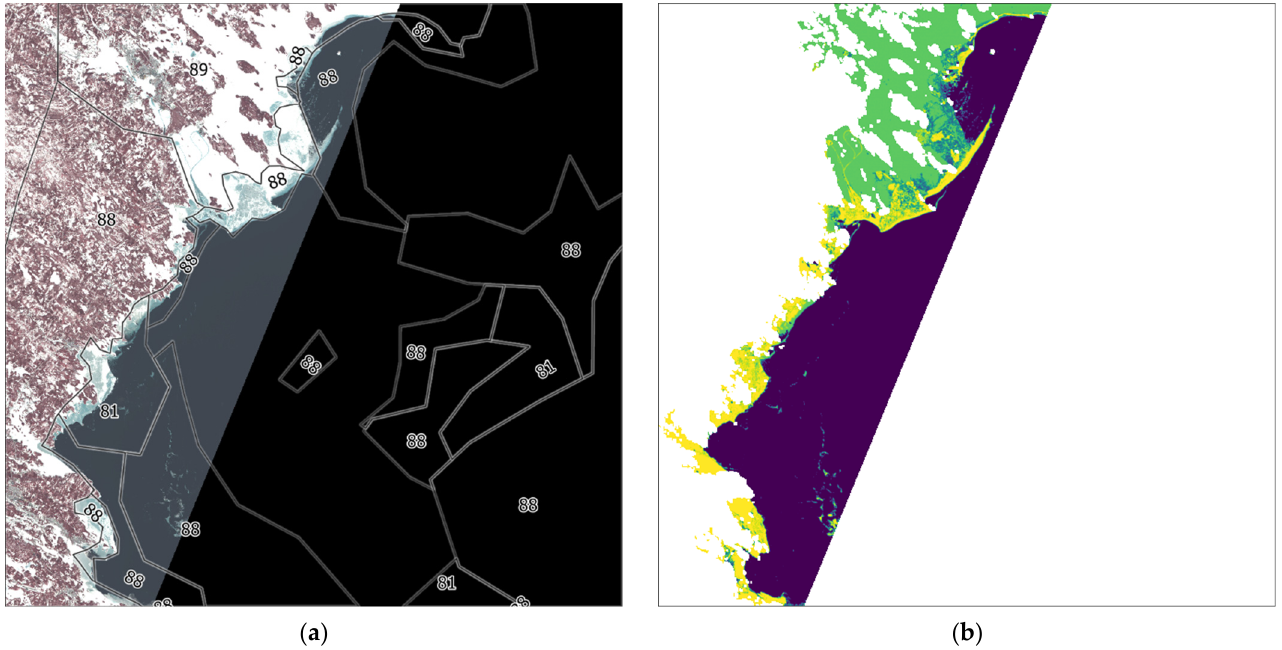
Figure 13. ( a ) Landsat-8 false color for 27 March 2019; BSH ice chart for 27 March 2019; ( b ) ICESOD classification.